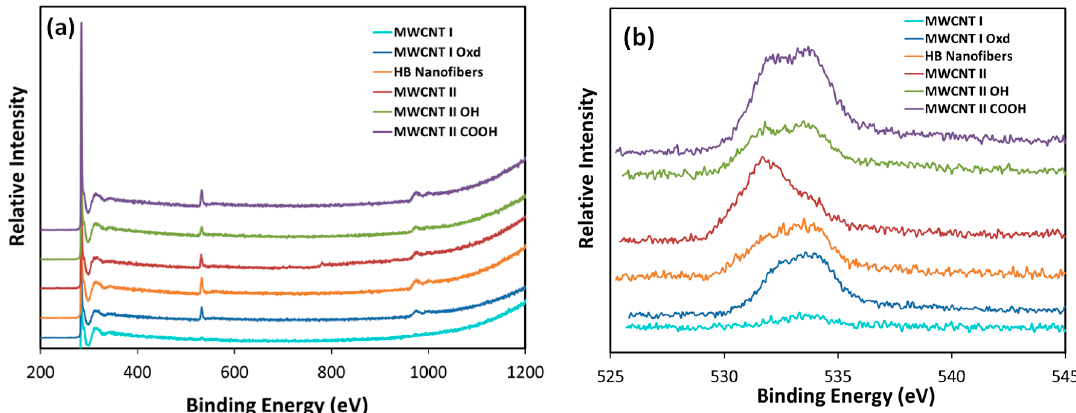
Figure 1. ( a ) XPS survey scans and ( b ) O 1s peaks for specialty carbons.